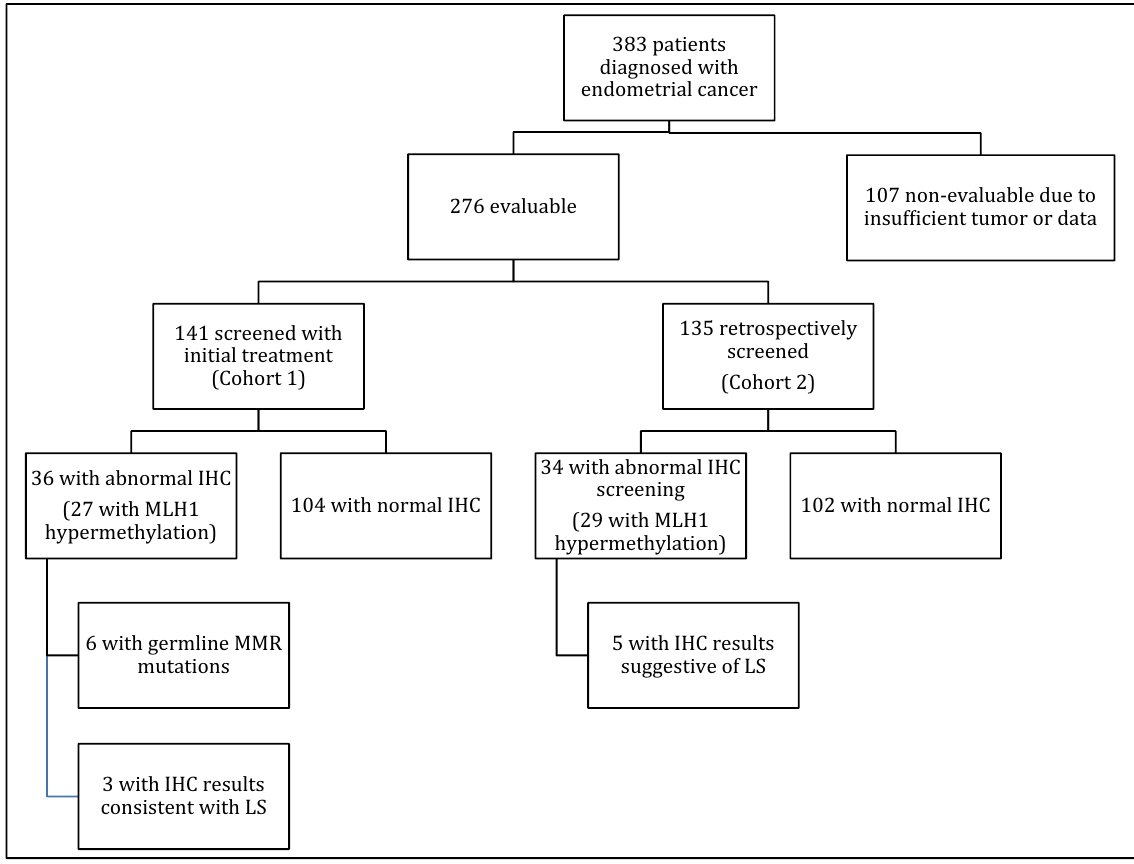
Figure 1. Study algorithm and screening